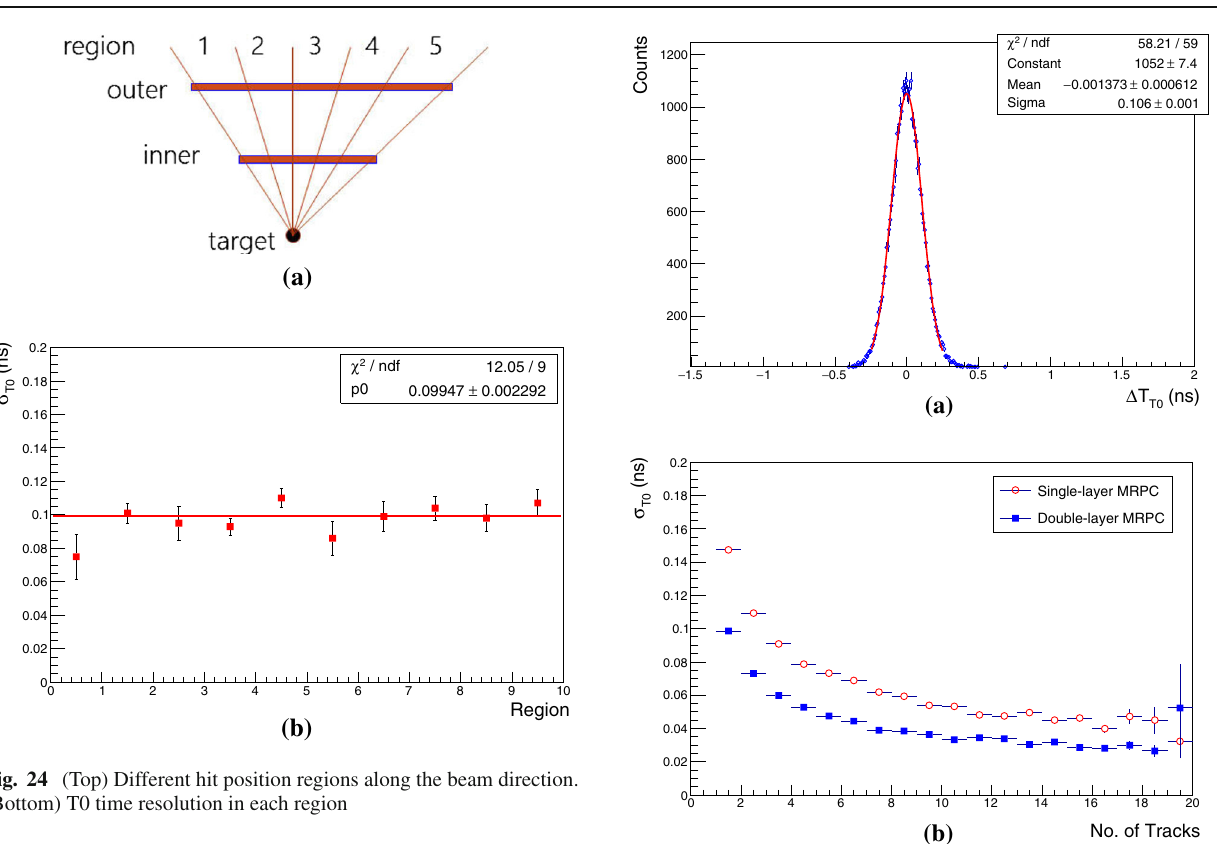
tion. Only the MRPCs, along with the boxes and FEE (the brownpartsinFig.16)wereincludedintheGEANT4simula- tion. The target and other supporting structure were ignored.